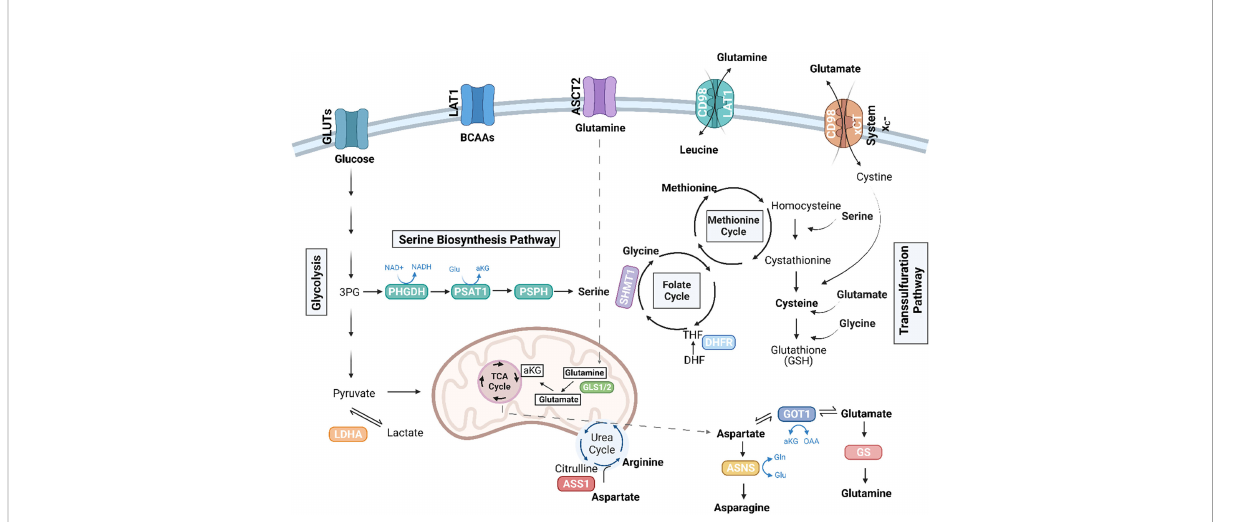
FIGURE 1 Amino acid pathways rewired in cancer. Illustration depicting amino acid pathways linked in an intricate metabolic network. Essential amino acids, including the branched chain amino acids (BCAAs), leucine, isoleucine, and valine, are imported from the extracellular environment, in part via the LAT1 ( SLC7A5 ) transporter. Glutamine (Gln) can be conditionally essential and is imported through ASCT2 ( SLC1A5 ). Glutaminase enzymes (GLS1/2) convert glutamine to glutamate (Glu), which can further be converted to alpha-ketoglutarate ( a KG) to enter the TCA cycle. The TCA cycle also generates intermediates, which give rise to non-essential amino acids, including aspartate and arginine. The de novo synthesis of arginine involves the conversion of citrulline to aspartate by argininosuccinate synthetase 1 (ASS1). TCA-cycle derived aspartate is converted to asparagine via ASNS, and GOT1 can convert aspartate to glutamate, which is further converted to glutamine by glutamine synthetase (GS). Serine, another non-essential amino acid, can be imported or synthesized de novo in the serine biosynthesis pathway (SBP), which diverts the 3P-glycerate (3PG) intermediate of glycolysis to generate serine via the enzymes, phosphoglycerate dehydrogenase (PHGDH), phosphoserine aminotransferase (PSAT1), and phosphoserine phosphatase (PSPH). Serine can further be converted to glycine by serine hydroxymethyltransferase (SHMT) (cytosolic SHMT1 isozyme shown above) to generate one-carbon units to fuel the folate cycle and the methionine cycles. Dihydrofolate reductase (DHFR) in the folate cycle catalyzes the reduction of dihydrofolate to tetrahydrofolate (THF). Cysteine is another non-essential amino acid that can be synthesized in the transsulfuration pathway or imported as cystine via the cystine/ glutamate antiporter, system x C -. The SBP, transsulfuration pathway, along with ASS1 and glutamine metabolism have been implicated in sarcoma biology. Figure was created with